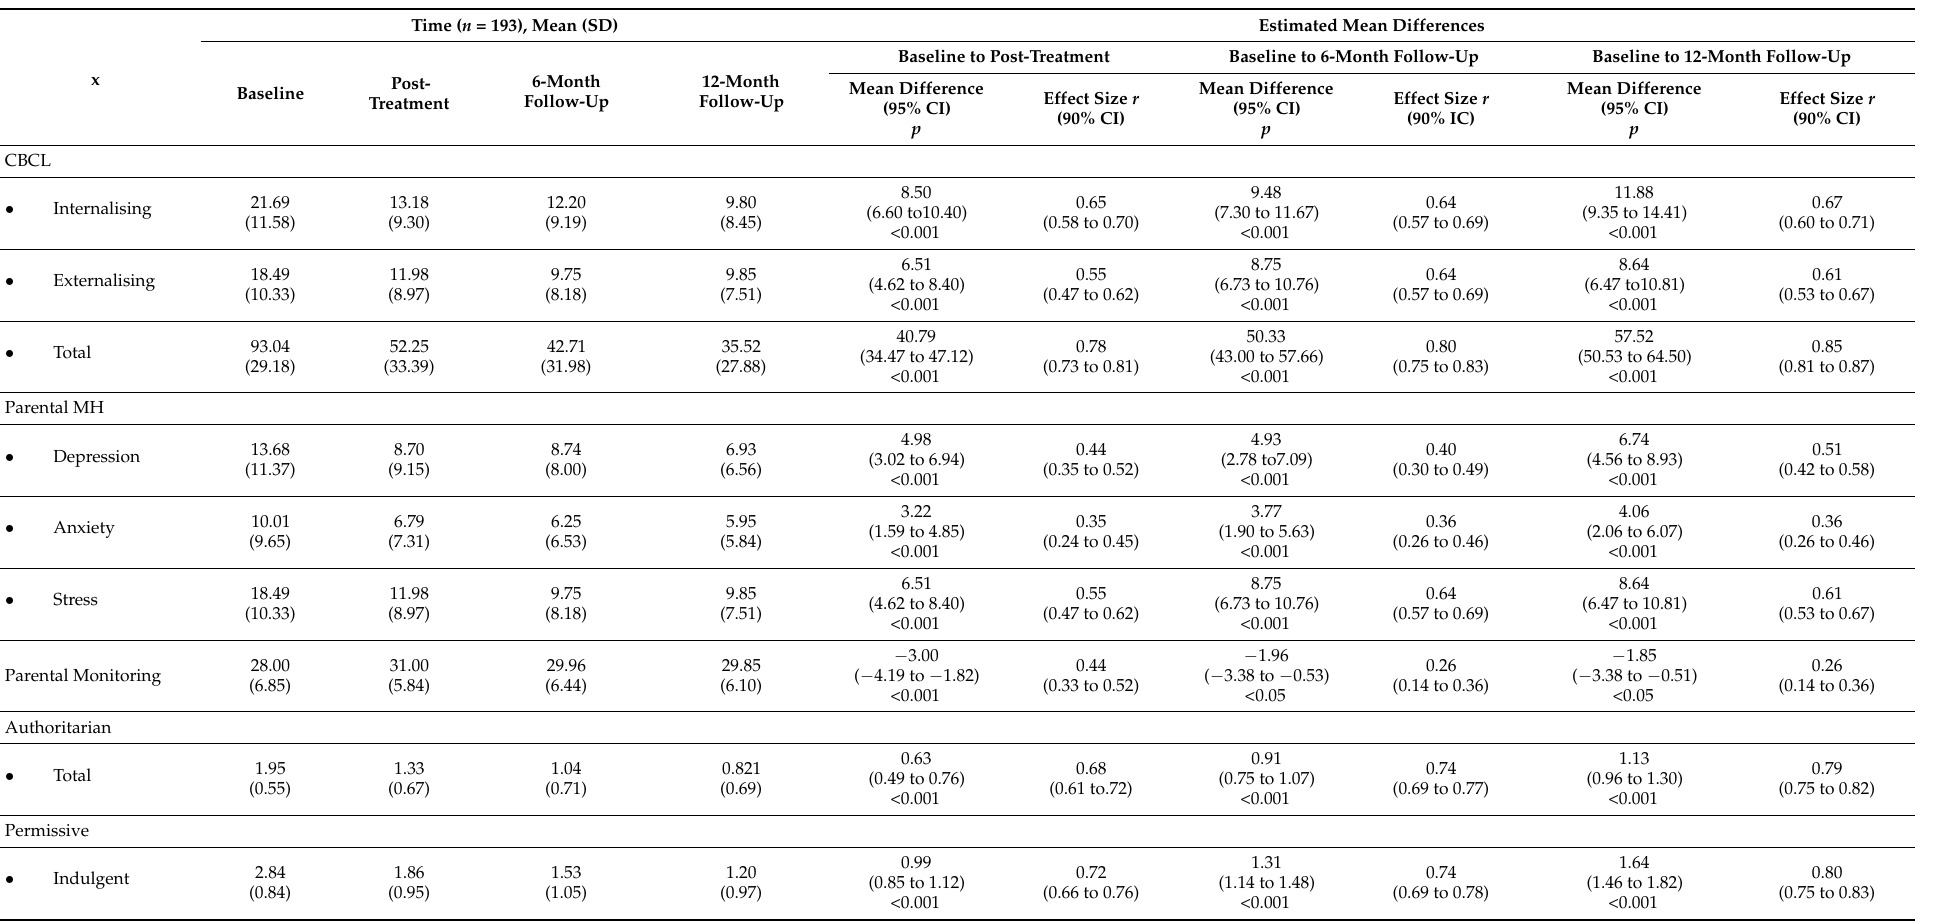
Table 2. CBCL, Parental mental health, Parental monitoring & Parenting Styles outcome measure: Summary of long-term results for MST research